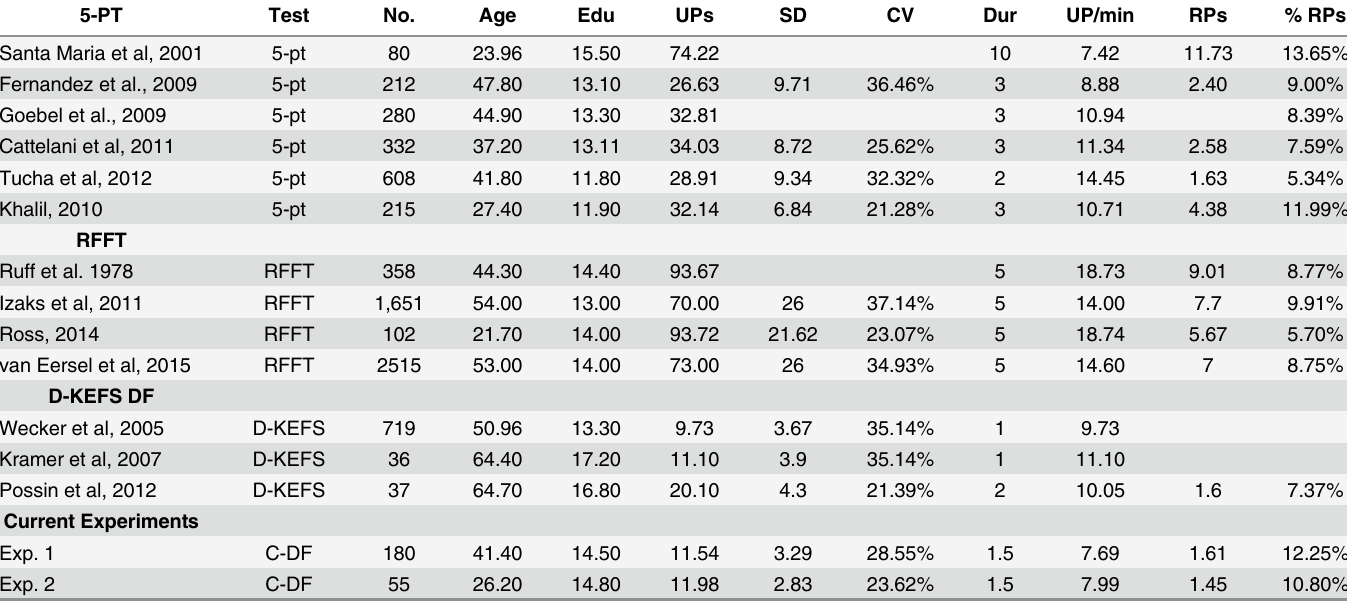
Table 1. Normative data in design fluency